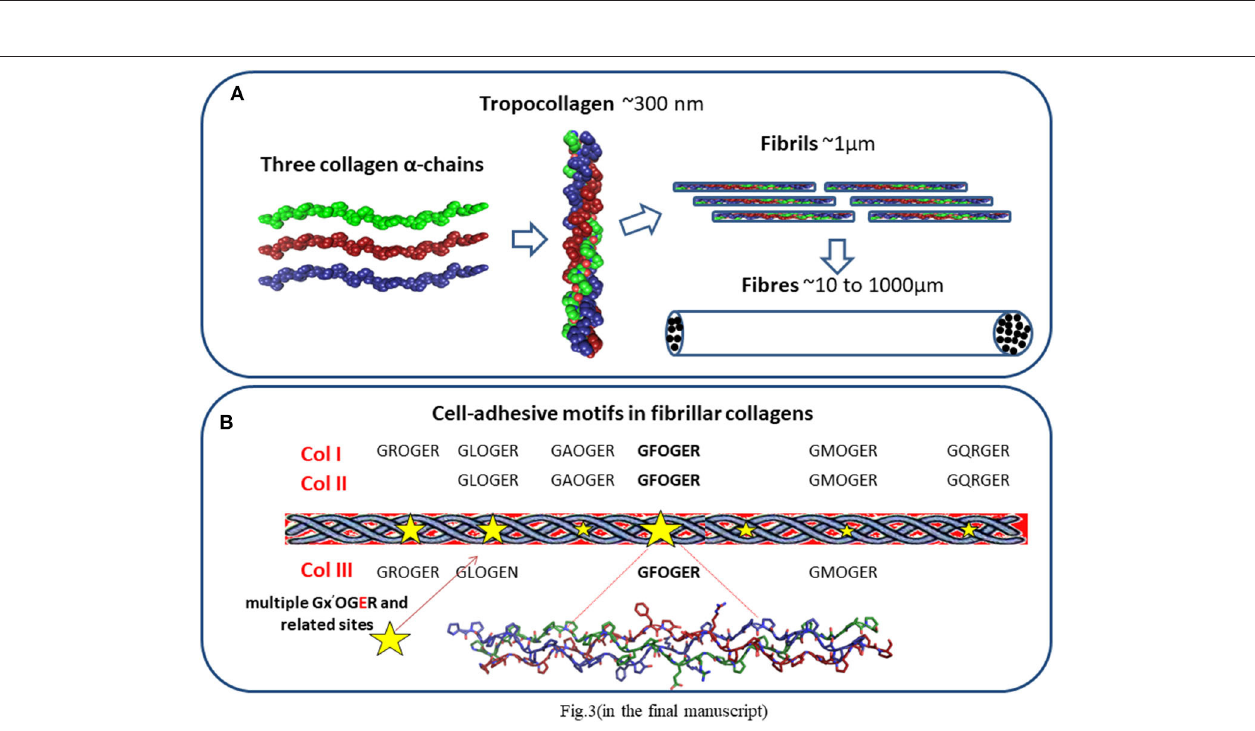
FIGURE 3 | (A) Collagen structure. Three polypeptide subunits ( α -chains) with a common triple helix configuration. These triple helices comprise a molecule of tropocollagen, the basic building block of collagen fibers and fibrils. (B) Distribution of cell-adhesive sequences in fibrillar collagens.